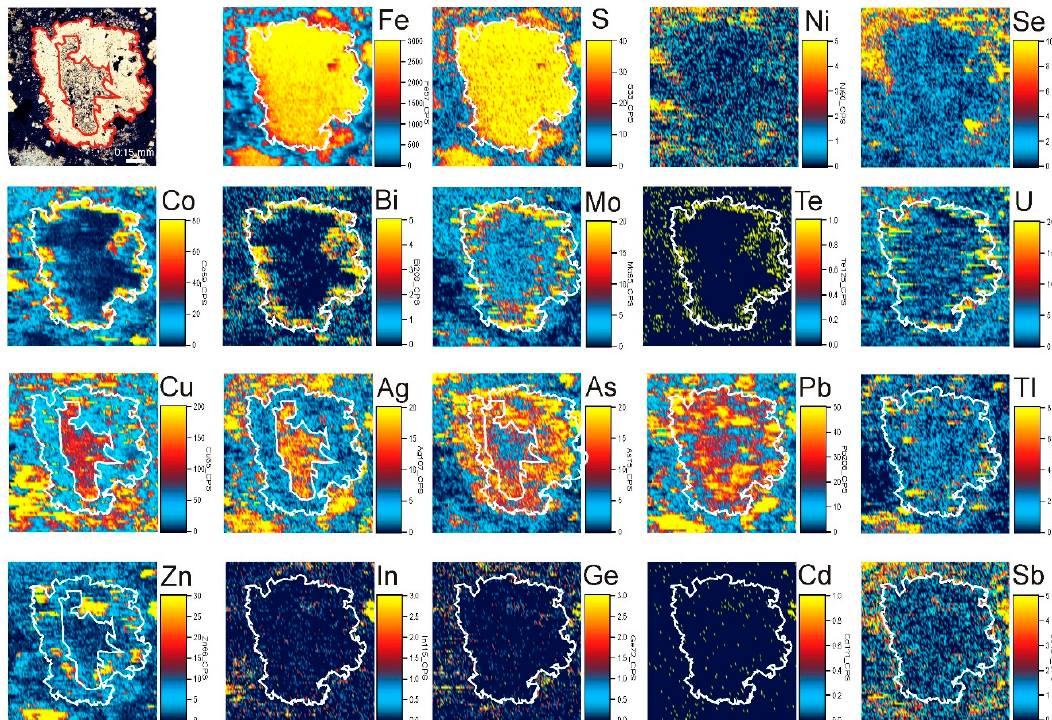
Figure 13. LA ‐ ICP ‐ MS trace element pattern of a nodular pyrite aggregate. The Ni and Se maps are Figure 13. LA-ICP-MS trace element pattern of a nodular pyrite aggregate. The Ni and Se maps are shown as example of no zoning inside the nodule. shown as example of no zoning inside the